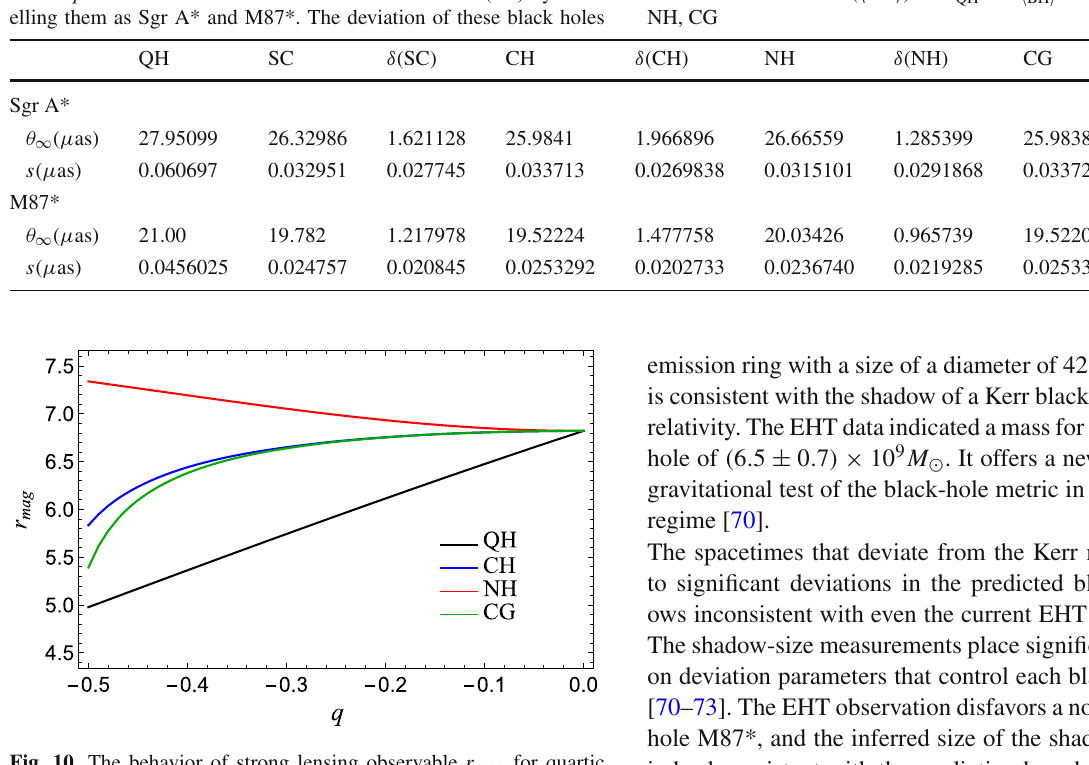
(BHs) from quartic Horndeski black hole at q = − 0 . 139322 have also been calculated where δ( (cid:15) BH (cid:16) ) = X QH − X (cid:15) BH (cid:16) with (cid:15) BH (cid:16) = SC, CH,